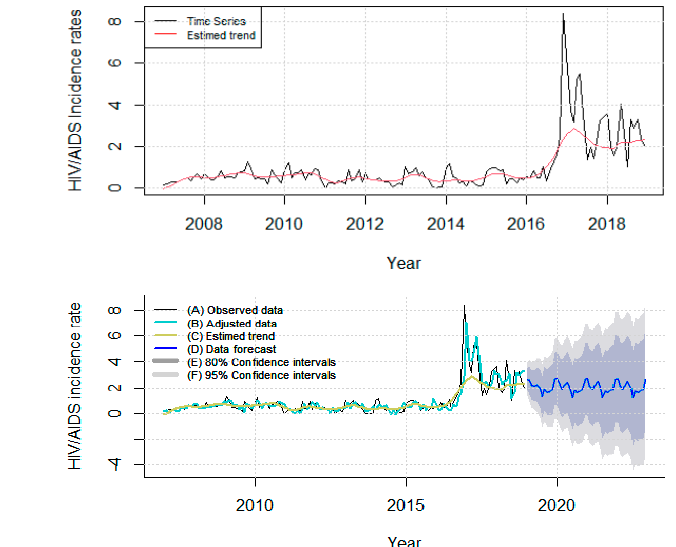
Figure 2. ( A ) Time series of the incidence rates (per 100,000 inhab.) of HIV infection and AIDS in Belém, PA, Brazil (2007–2018). ( B ) The STL + ARIMA (2,1,2) model adjusted to the transformed HIV/AIDS incidence rates (per 100,000 inhab.) and the forecast for Belém, PA, Brazil (2019–2022).